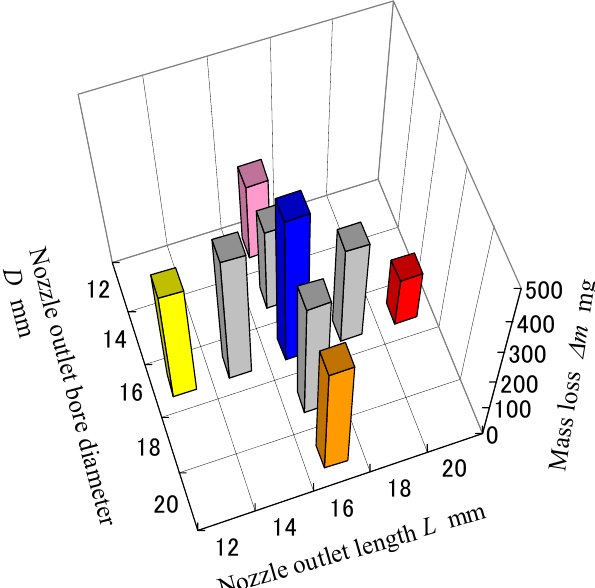
Fig. 3 Mass loss at optimum standoff distance for various D and L